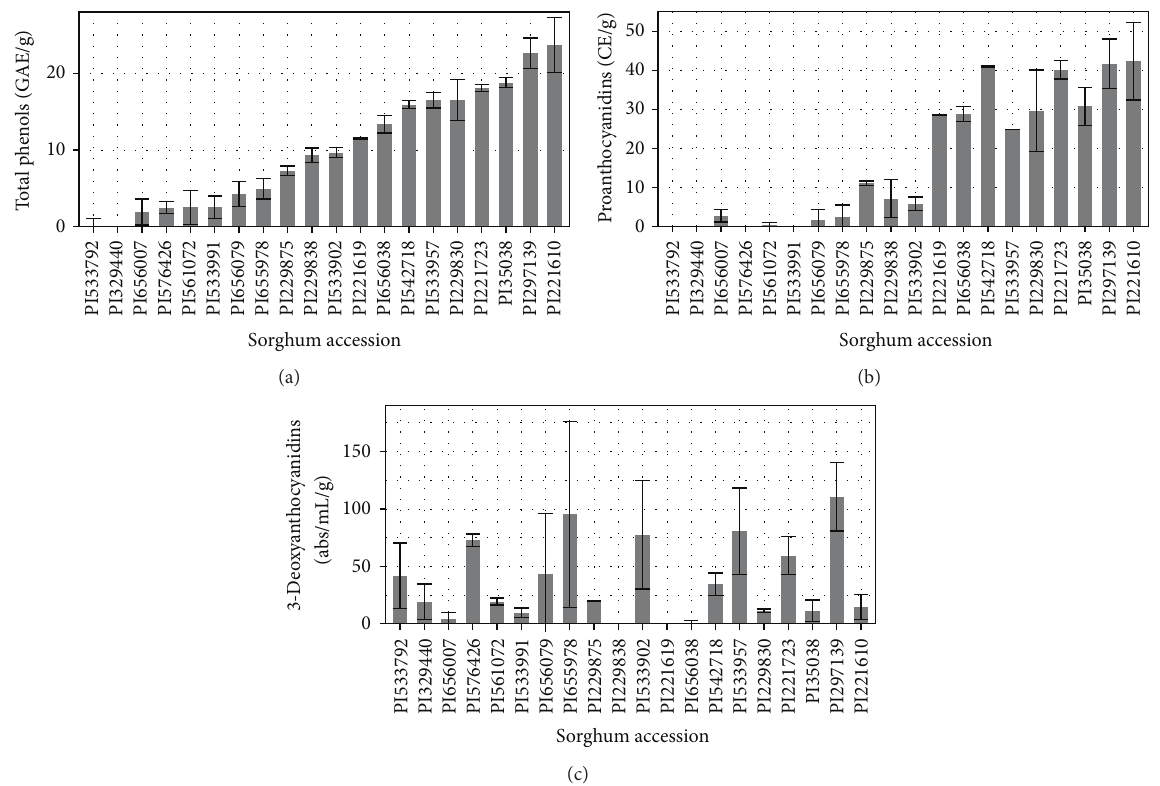
Figure 2: Polyphenol concentrations in the grain of 20 sorghum accessions. NIRS estimates of (a) total phenol concentrations (GAE/g), (b) proanthocyanidin concentrations (CE/g), and (c) 3-deoxyanthocyanidin concentrations (abs)/mL/g, ordered from lowest total phenols to highest ones. Error bars represent the means of triplicate experiments ± SD.